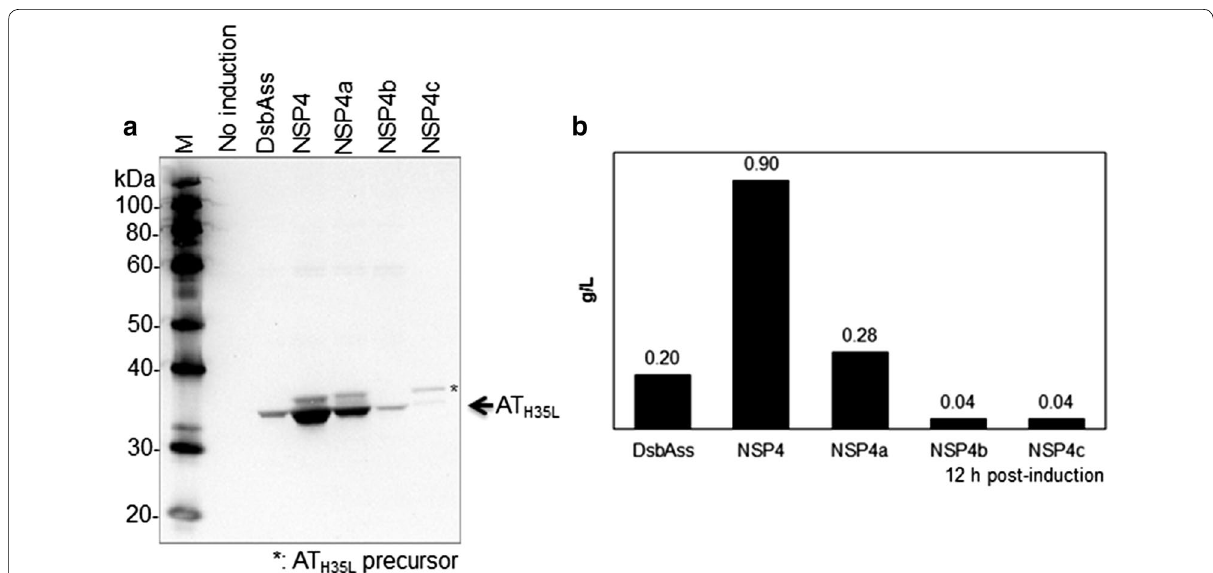
Fig. 4 Screening of Set II novel signal peptides for AT H35L secretion in 1L fed-batch bioreactor. a Western blot analyses of secreted AT H35L protein in cell culture medium. b Quantification of extracellular AT H35L protein in cell culture medium at 12 h